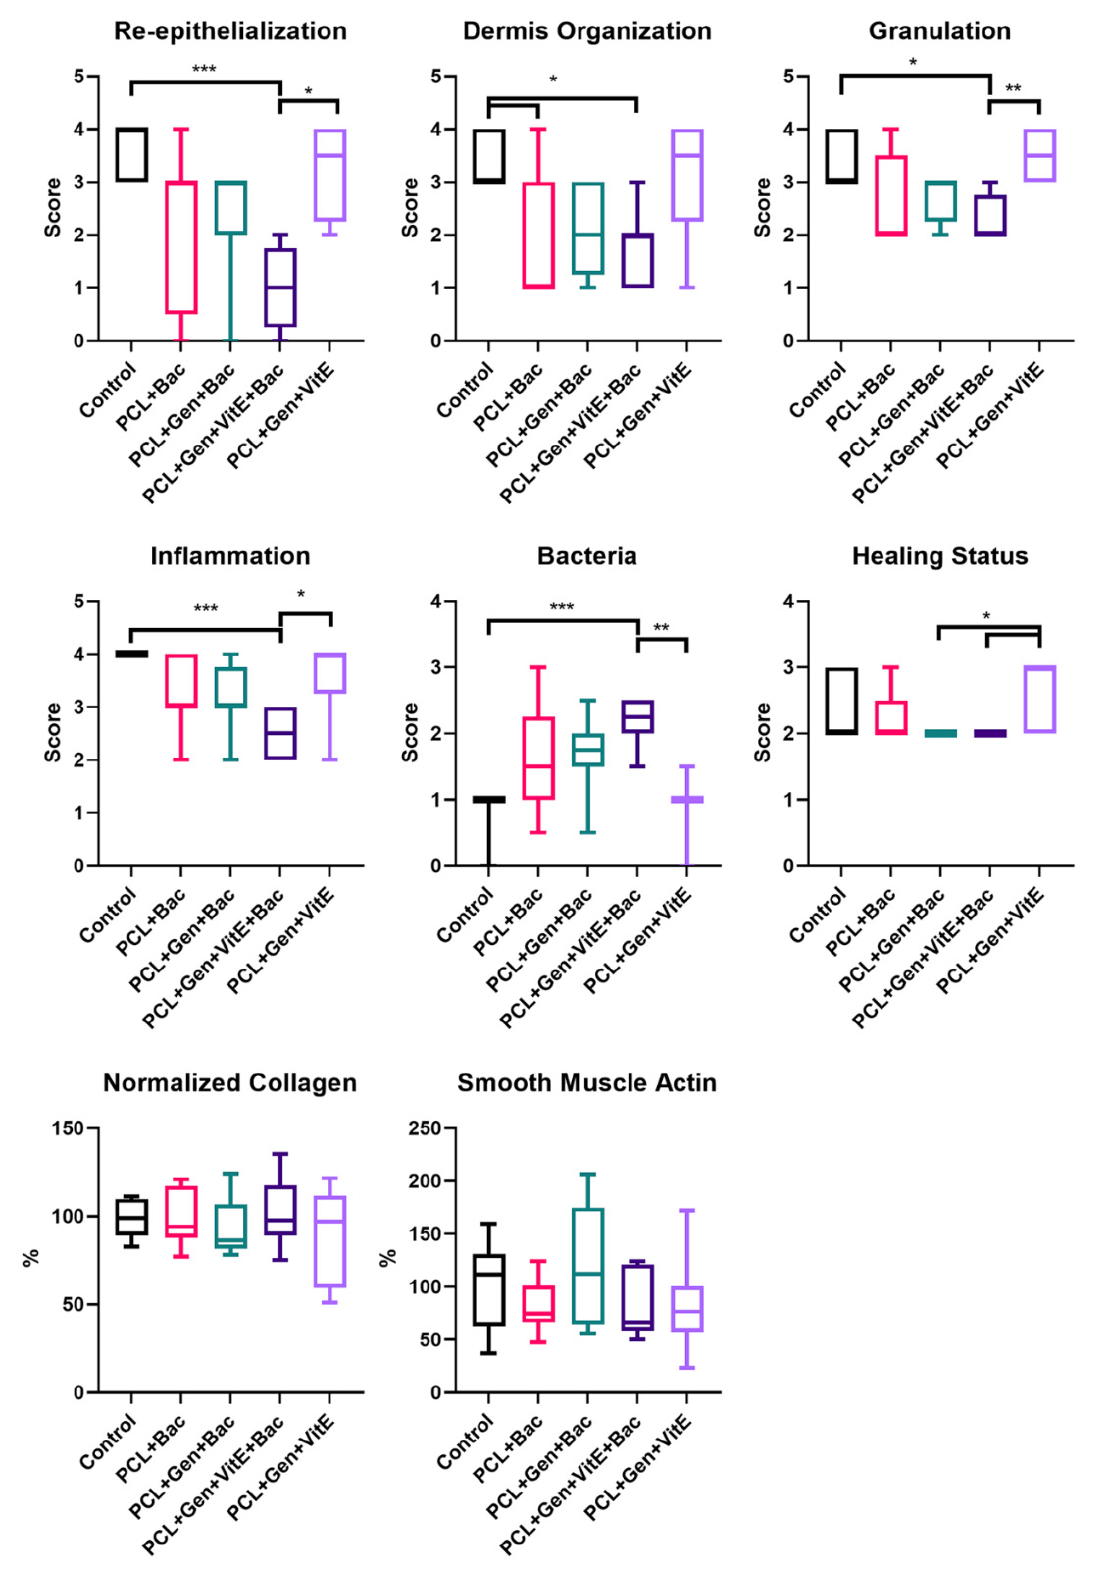
Figure 13. Histologic evaluation according to Table 2. Defects treated with PCL nanofibers (PCL), gentamicin (Gen), α -tocopherol acetate (VitE), and infected by S. aureus and P. aeruginosa (Bac) or untreated defects (control). Significant difference * p < 0.05, ** p < 0.01, *** p < 0.001.